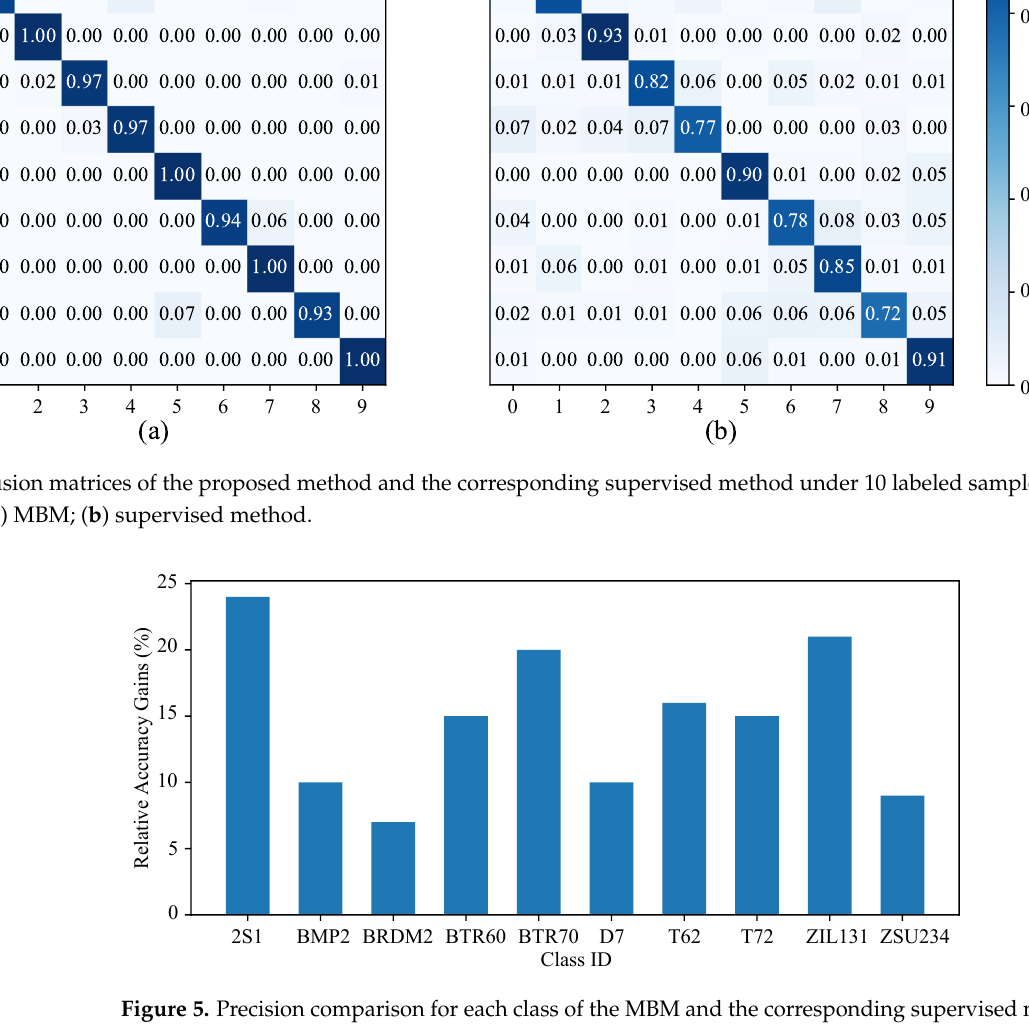
Figure 5. Precision comparison for each class of the MBM and the corresponding supervised method, where the Y-axis denotes per class classification accuracy improvement of the MBM relative to the corresponding supervised method, and the X-axis denotes the class index of each